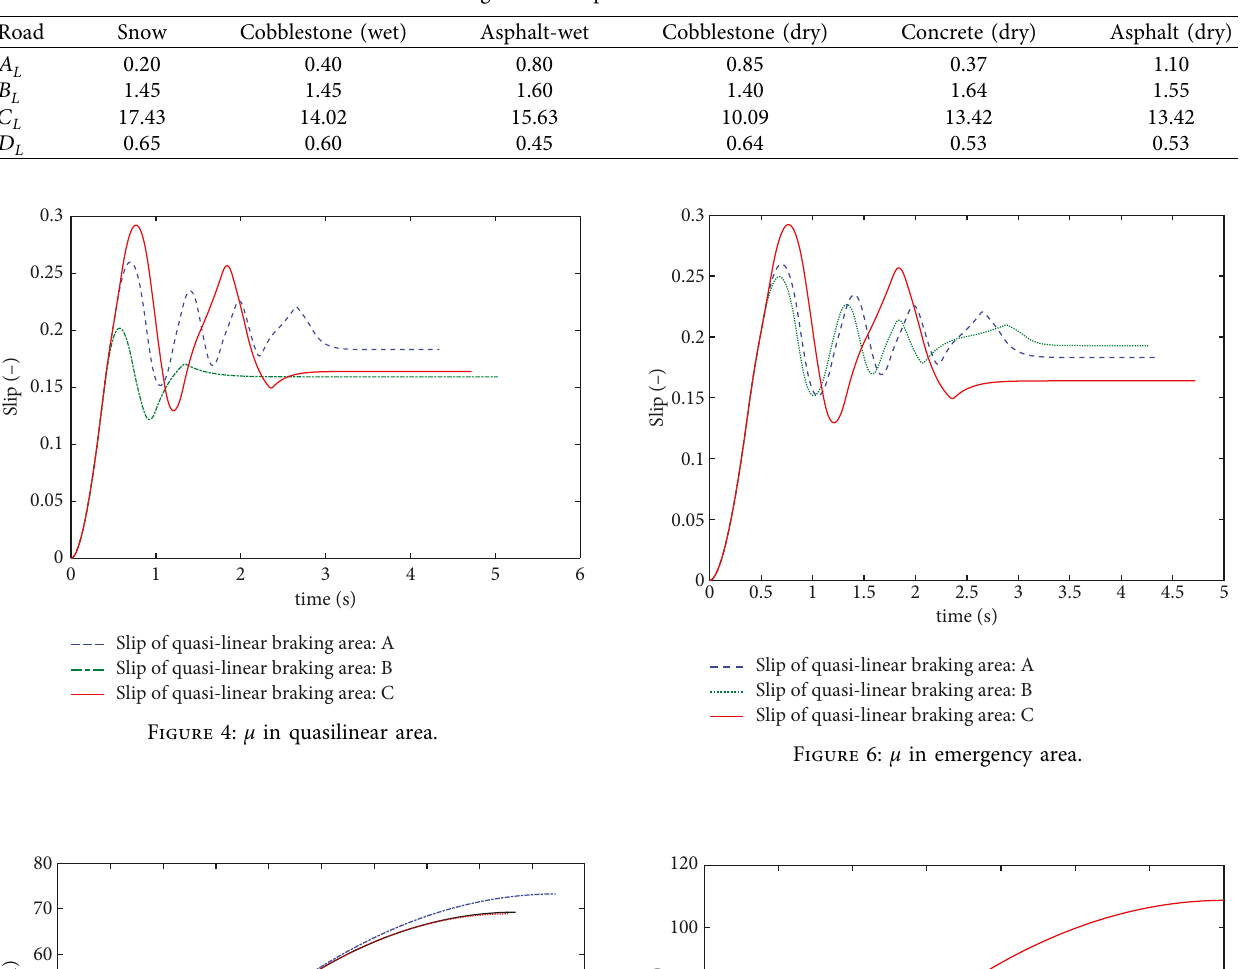
Table 2: Magic formula parameters of different